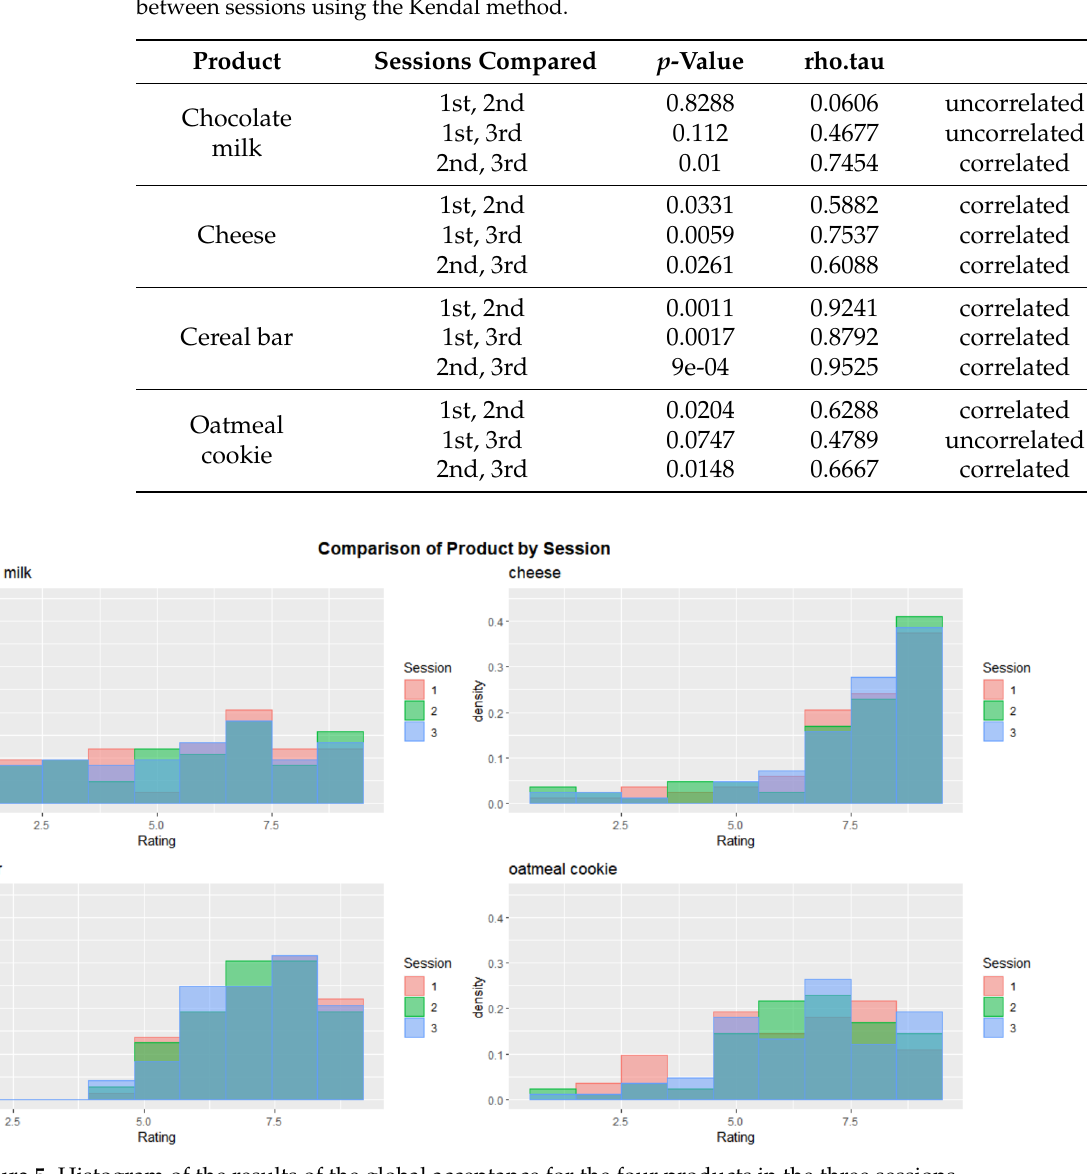
Figure 5. Histogram of the results of the global acceptance for the four products in the three